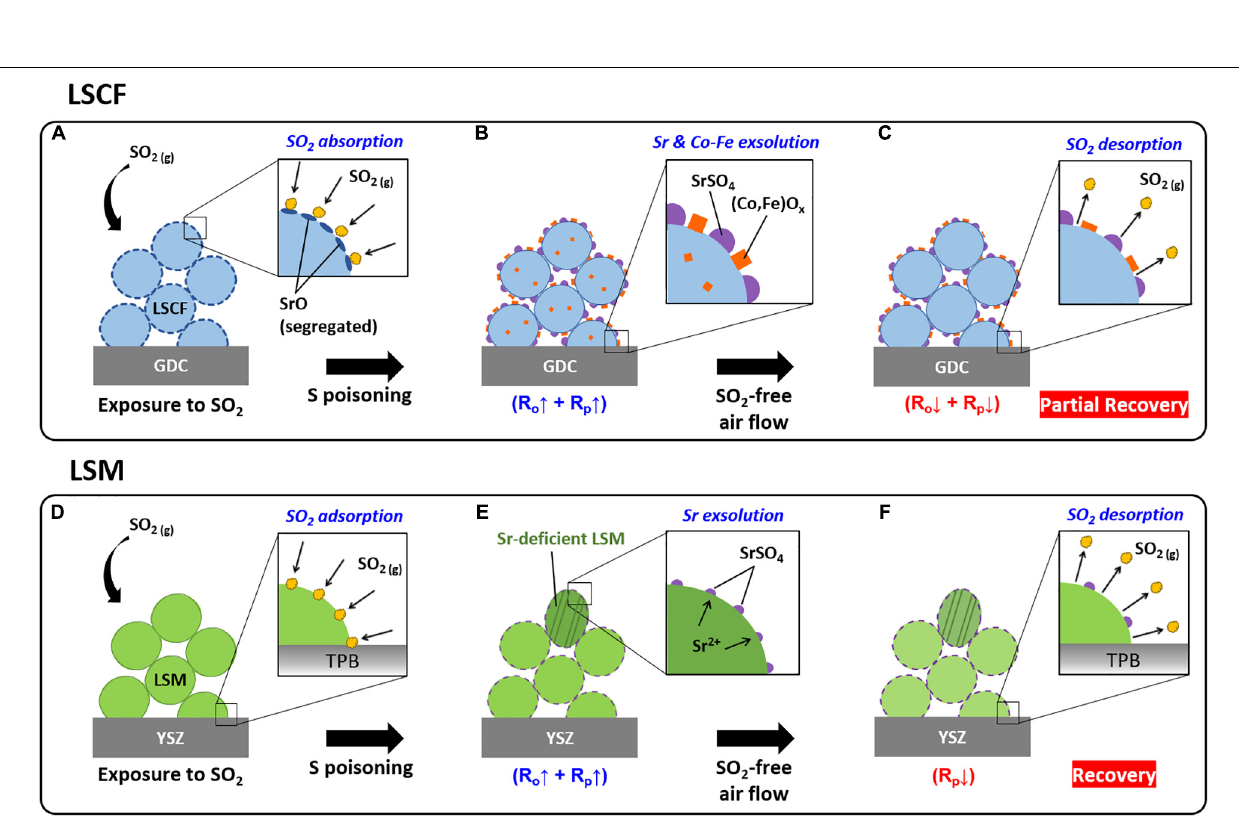
Frontiers in Energy Research |